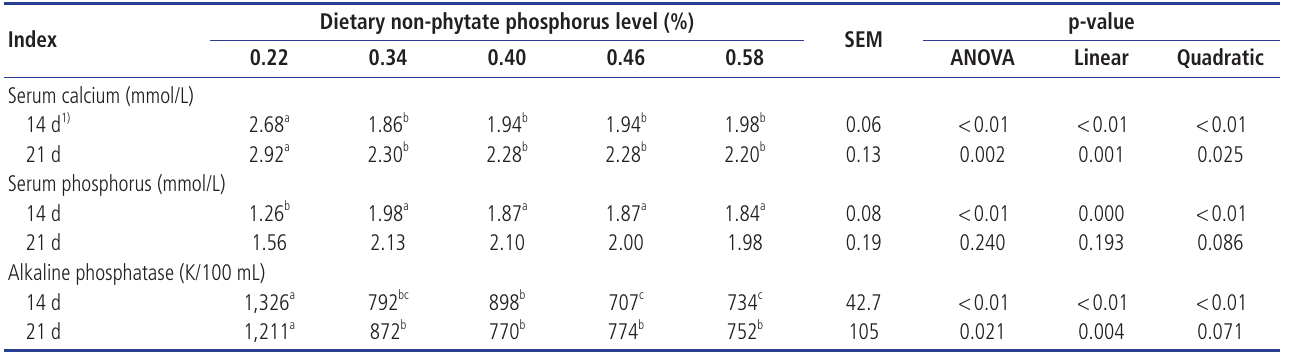
Table 3. Effect of dietary non-phytate phosphorus levels on the serum parameters of ducks Dietary non-phytate phosphorus level (%) Index